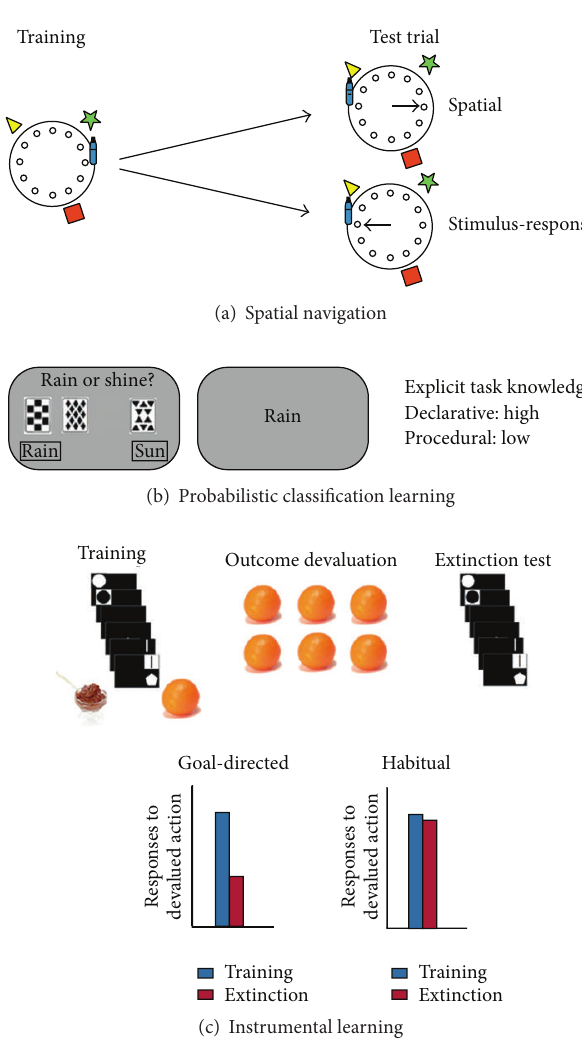
Figure 4: Behavioural tests to distinguish between multiple mem- ory systems: (a) spatial navigation, (b) probabilistic classification learning, and (c) instrumental learning